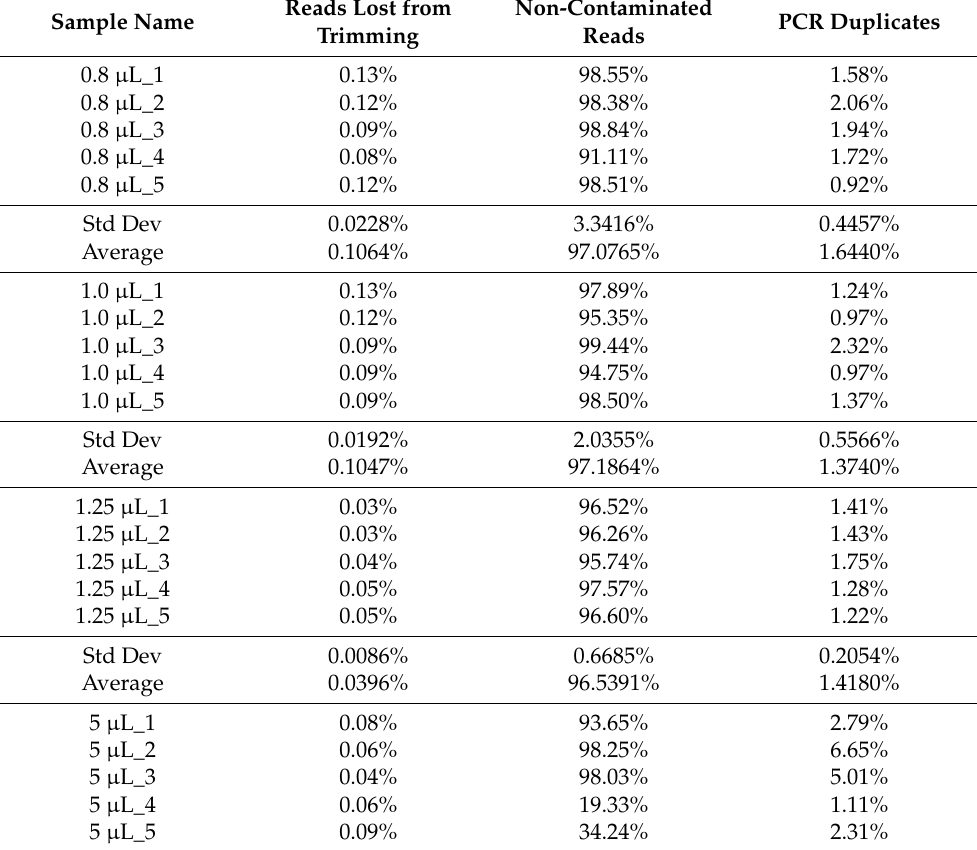
Table A3. Sample read processing summary. Total reads from all samples were used as input for read trimming in Trim Galore [75]. After read trimming, all samples were down-sampled to 200 × sequence depth prior to decontamination with FASTQ-Screen [77] and duplicate removal with dedupe.sh from BBTools [76]. p -values were calculated using one-way ANOVA with an alpha of 0.05 in Microscoft Excel ®